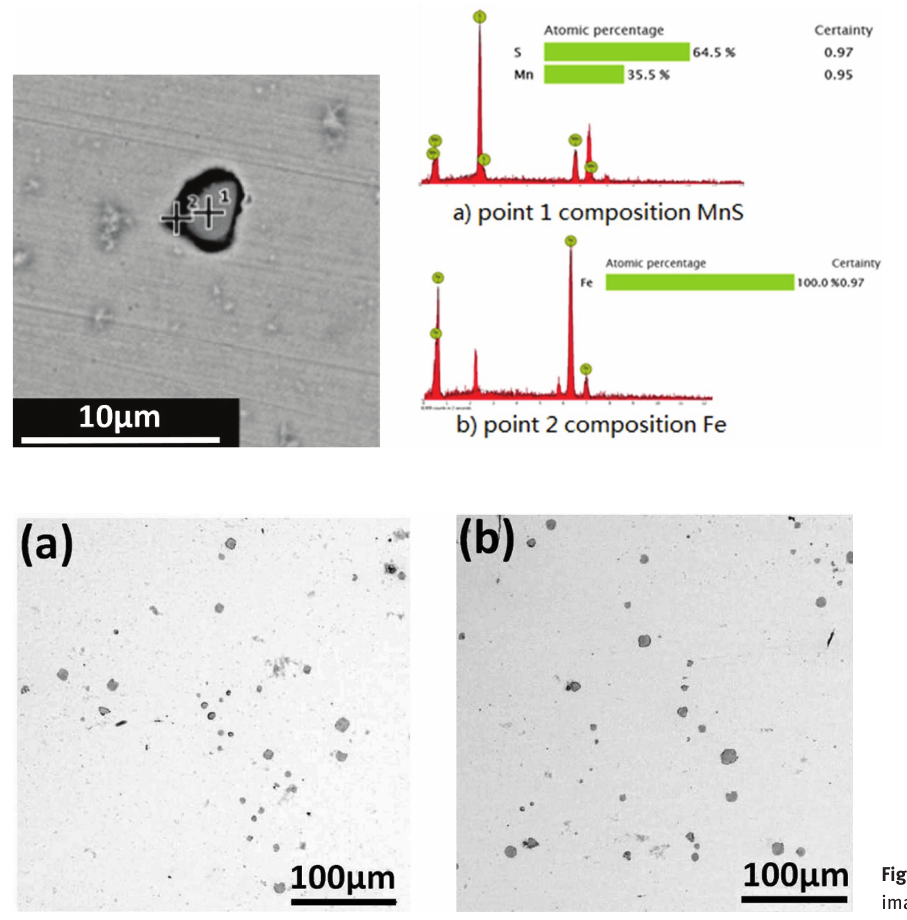
Figure 5: Low magnification SEM images of samples after